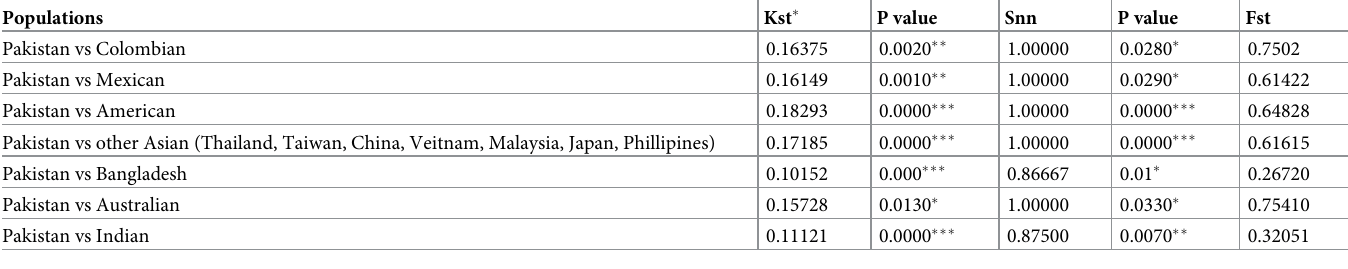
Table 1. Statistical tests for genetic differentiation and gene flow between Papaya ringspot virus populations from Pakistan with the populations from Colombia, Mexico, America, Other Asian regions, Bangladesh, Australia and India based on the CP gene nucleotide sequences. Populations